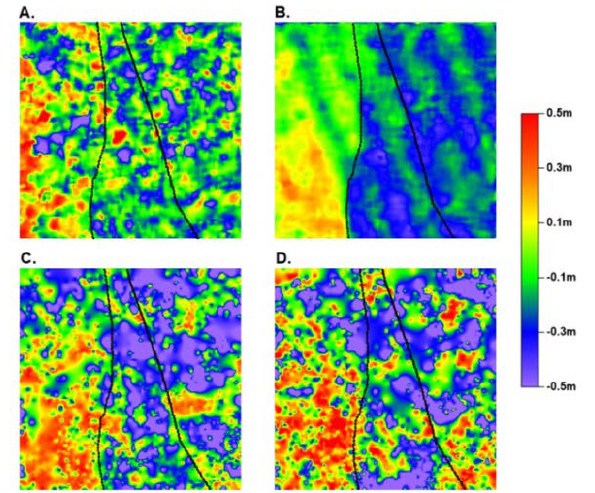
Figure 2. Displacement fields in the Y direction from bare earth point clouds. Fault traces shown by black lines. (A) ICP results of differenced point clouds from 2003 to September 2014. (B) ICP results of differenced point clouds from June 2014 to September 2014. (C) PIV results of differenced point clouds from 2003 to September 2014. (D) PIV results of differenced point clouds from June 2014 to September 2014.